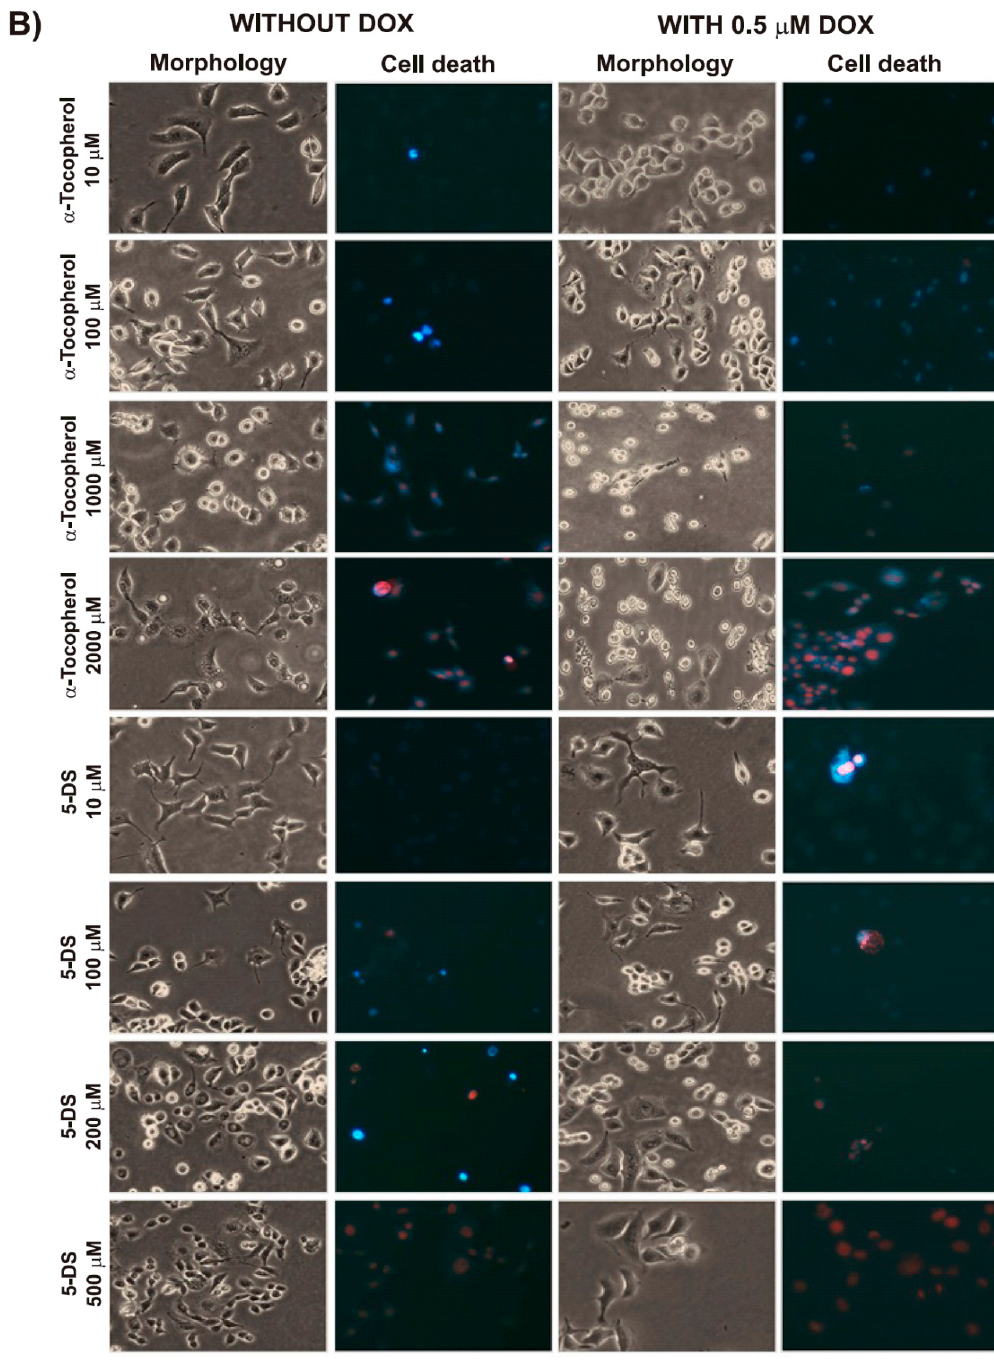
Figure 3. Morphology and cell death of B14 cells at 24 h after cell treatment with the investigated compounds administered alone (0.5 μ M doxorubicin (DOX), α -Tocopherol, and doxyl stearate nitroxides: 5-DS, Met-12-DS, and 16-DS) or in combination: 0.5 μ M DOX with α -Tocopherol or with the nitroxides. Cell death was visualized using fluorescent double staining with propidium iodide (PI) and Hoechst 33258. Cell monolayers were analysed using an optical microscopy (morphology) or with the use of an inverted fluorescence microscopy (cell death) (Olympus IX70, Tokyo, Japan) under magnification 150×. Cells were classified as viable (blue fluorescent), early apoptotic (bright blue fluorescent), late apoptotic (blue-violet fluorescent), and necrotic (red fluorescent cells). ( A ) Control cells, DOX alone, Met-12-DS or 16-DS-treated cells; ( B ) α -Tocopherol, 5-DS.